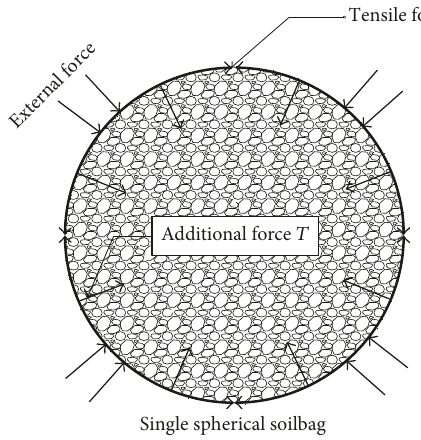
Figure 3: Schematic view of the forces acting on a spherical